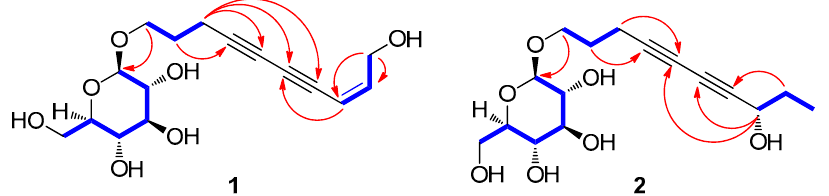
Figure 2. 1 H- 1 H COSY (bold blue lines) and key HMBC (red arrows) correlations of 1 and 2 . Compound 2 was isolated as a colorless amorphous gum, and its IR spectrum showed absorption bands for hydroxy (3374 cm − 1 ) and acetylenic (2205 cm − 1 ) groups. Its peak at m / z 329.1598 [M + H] + (calculated for C 16 H 25 O 7 , 329.1600, Figure S7) and NMR data